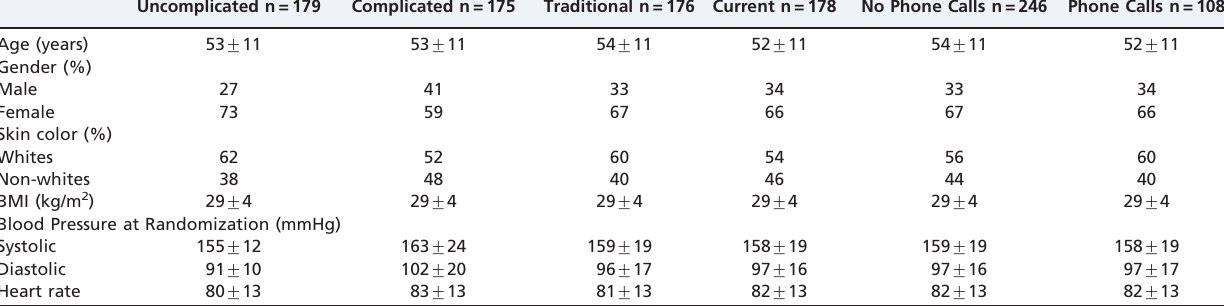
Table 1 - Study groups